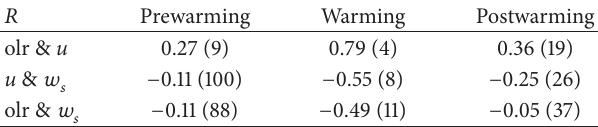
Table 1: The correlation coefficients among olr, 𝑢 , and 𝑤 𝑠 used in regression model during three periods. The number in the bracket represents the effective number (𝑁 eff ) of DOF.